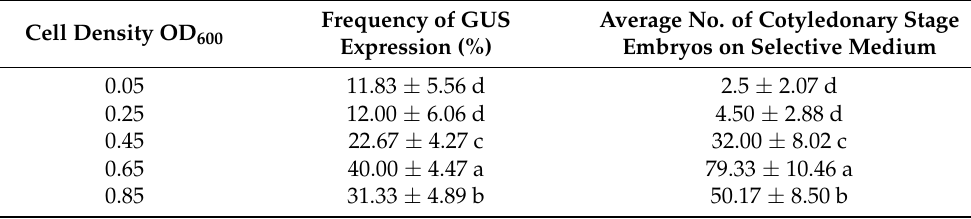
Figure 1. Stable expression of GUS in FECs ( A ) and GFP in cotyledons ( B ) under different Agrobac- terium cell densities. ( A ) GUS staining of FECs. FECs were taken from the last time on GD medium plates. After GUS staining, pictures were taken under an ultradeep field microscope. ( B ) Cotyledons on MSN medium under white light and fluorescence. Red arrows point to somatic embryos with green fluorescence. Table 1. Effects of Agrobacterium cell density on cassava SC8 transformation.